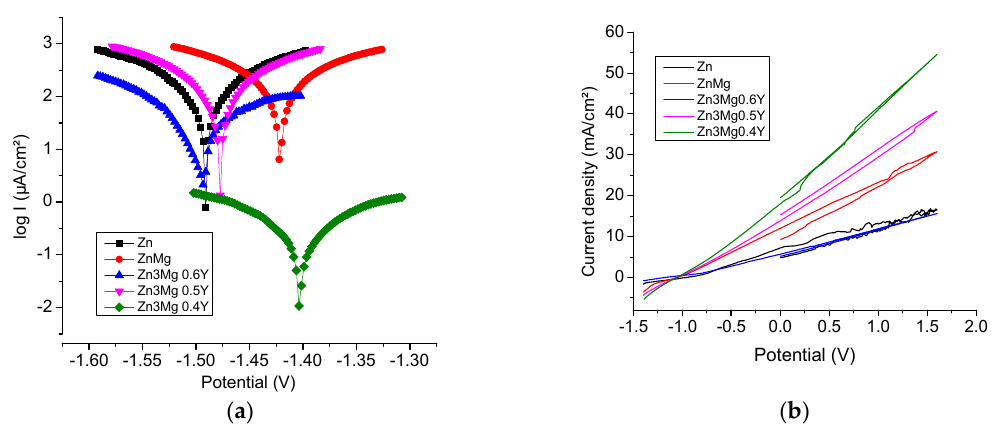
Figure 6. Linear and cyclic potentiometry of the samples. ( a ) Tafel diagram and ( b ) cyclic potentiometry.